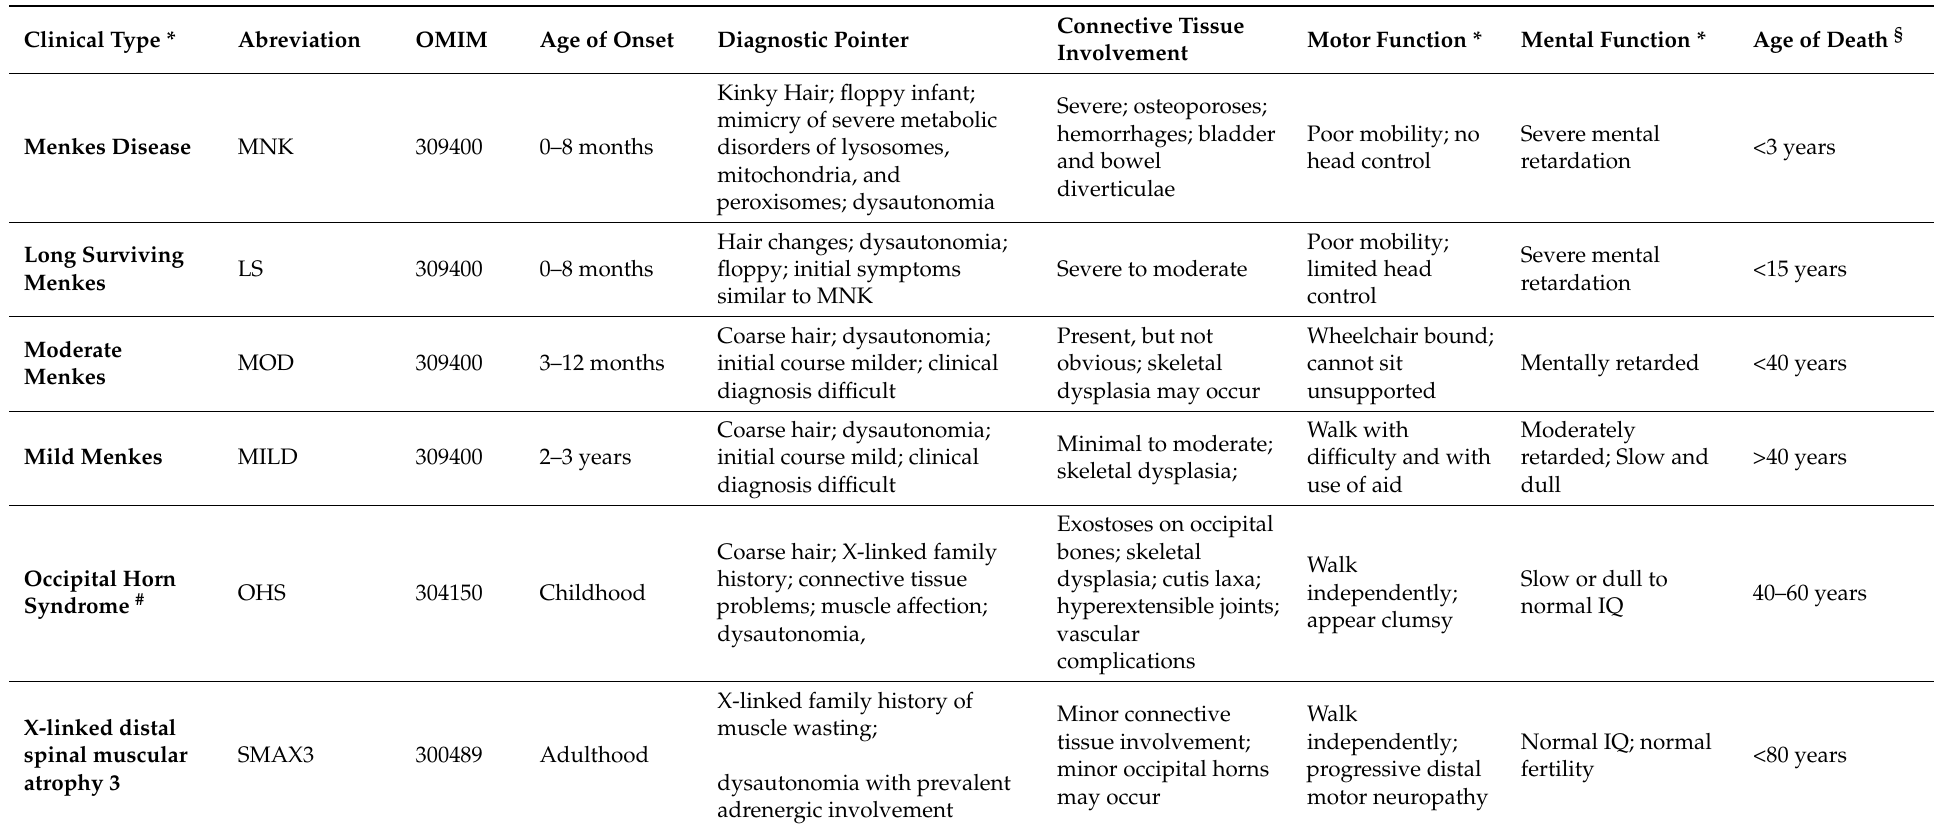
Table 1. Clinical Phenotypes of ATP7A-linked